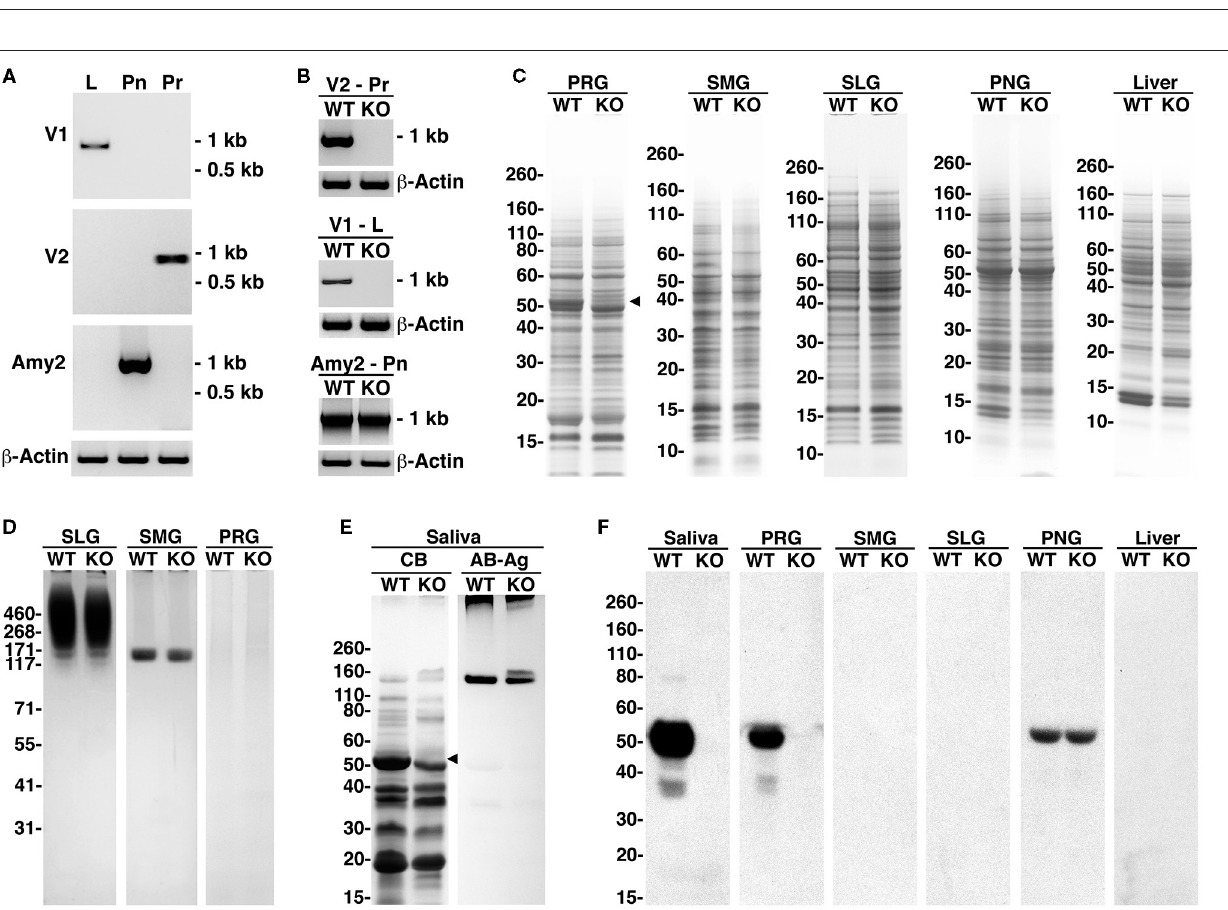
FIGURE 2 | embryonic stem (ES) cells ( + / + ) and correctly targeted ES cells ( + /–) digested with Nhe I and probed with either probe A or probe B. Probe A expected sizes are 10.2kb ( + / + ) and 7.6kb ( + /–). Probe B expected sizes are 6.6kb ( + / + ) and 5.7kb ( + /–). (C) PCR genotyping of F1 agouti mice to distinguish the absence ( + / + ) or presence ( + /–) of germline transmission and correct insertion of the 5 ′ - and 3 ′ -ends of the targeted allele using primer pairs P1 and P2, as shown in (B) . (D) Genotyping before neo insert deletion. Expected amplicon sizes are 232 bp ( + / + ) and 638 bp ( + /–). (E) PCR genotyping of male progeny for neo deletion after mating heterozygous F1 agouti females to a FLPeR male. Expected amplicons sizes are 998 bp ( + / + ) and 681 bp ( + /–). (F) Comparisons of the body weights of male and female wild-type (WT) and Amy1 knockout (KO) mice from 3 to 9 weeks of age. (G) Comparisons of the body lengths of male and female WT and Amy1 KO mice from 3 to 9 weeks of age. (H) Saliva flow stimulated by subcutaneous injection of muscarinic cholinergic and β -adrenergic agonists measured at 5-min intervals after injection and the volumes normalized to body weight (BW). Results are the mean ± SE from five mice of each genotype. There are no statistical differences between the two strains of mice (two-tailed unpaired t -test: P > 0.05).